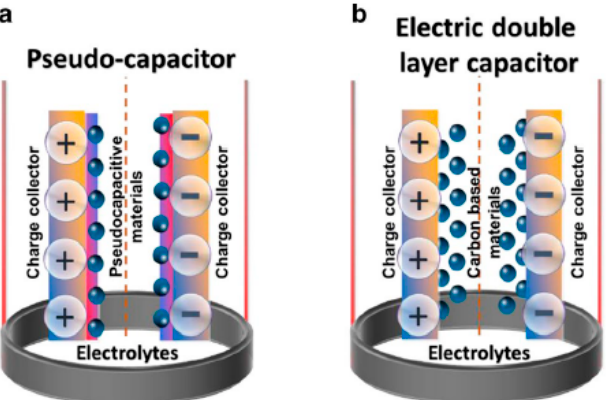
Figure 18. Schematic illustration with general mechanism of ( a ) a pseudocapacitor and ( b ) an electric double layer capacitor. Reprinted with permission from Ref. [8].